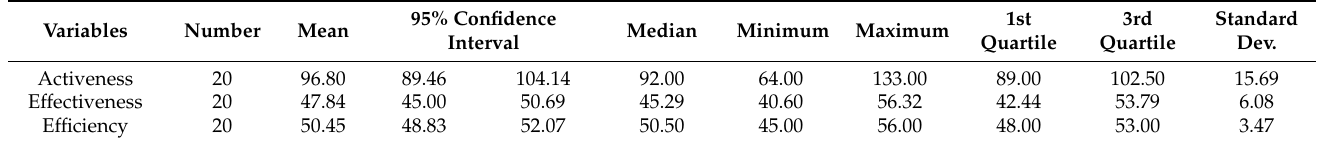
Table 4. Activeness, effectiveness and efficiency of